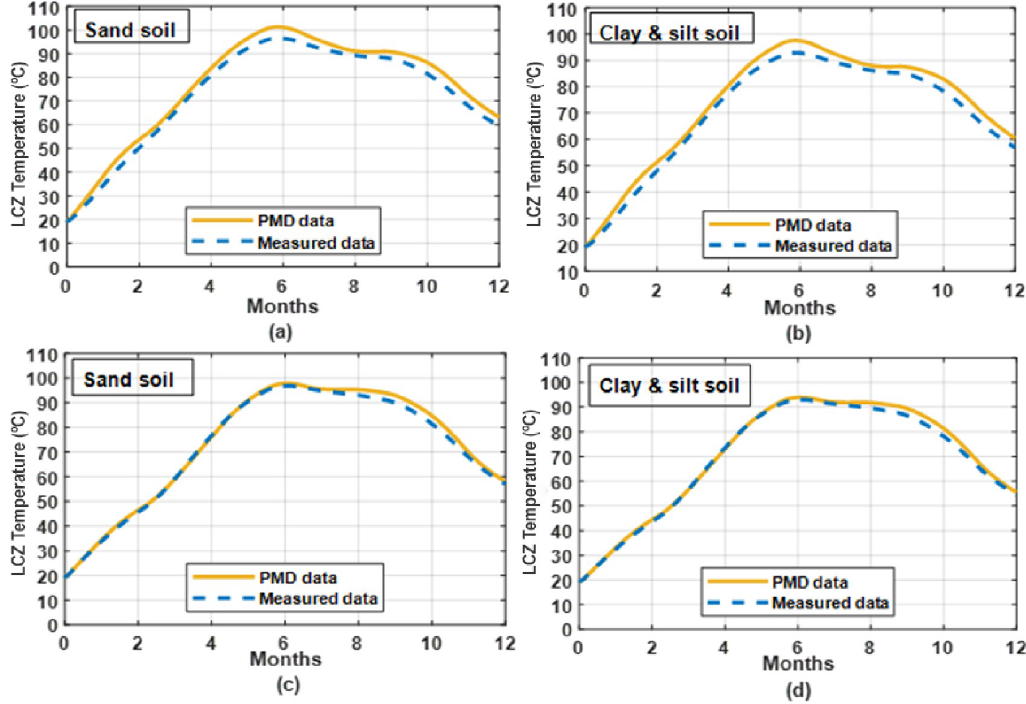
Fig 6. Annual LCZ temperature with a different type of soil under the solar pond for whole year simulation under PMD and measured climatic conditions of Lahore (a), (b) and Islamabad (c), (d).